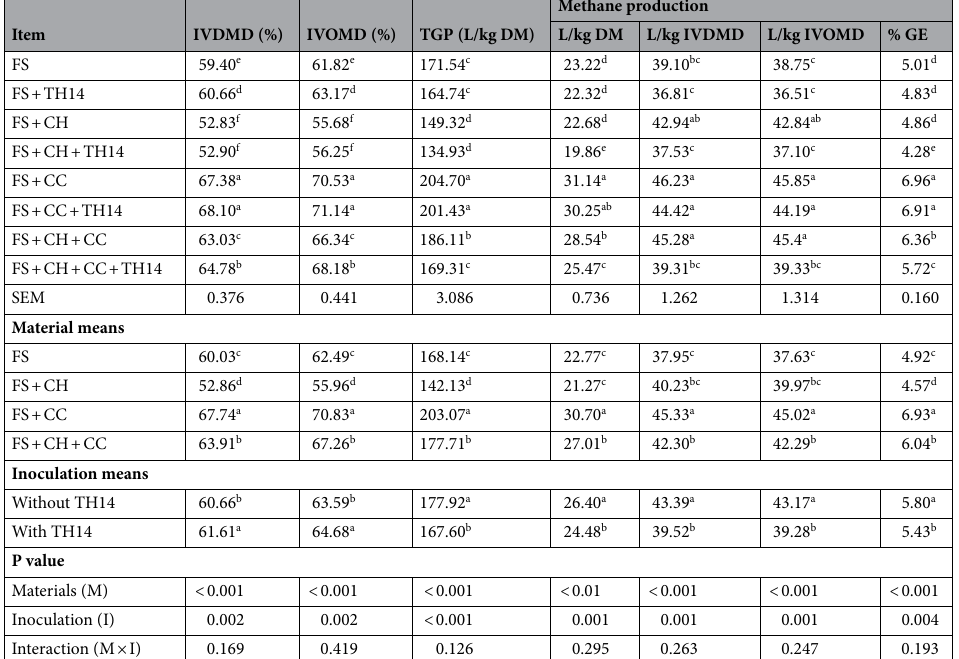
Table 6. In vitro digestibility, total gas production and methane production of the FS mixture silages after 48-h incubation. FS forage sorghum, CH Cavalcade hay, CC cassava chip, TH14 L. casei TH14 inoculant, SEM standard error of the means, IVDMD in vitro dry matter digestibility, IVOMD in vitro organic matter digestibility, TGP total gas production, GE gross energy. Means within columns with difference superscript letters differ at p <